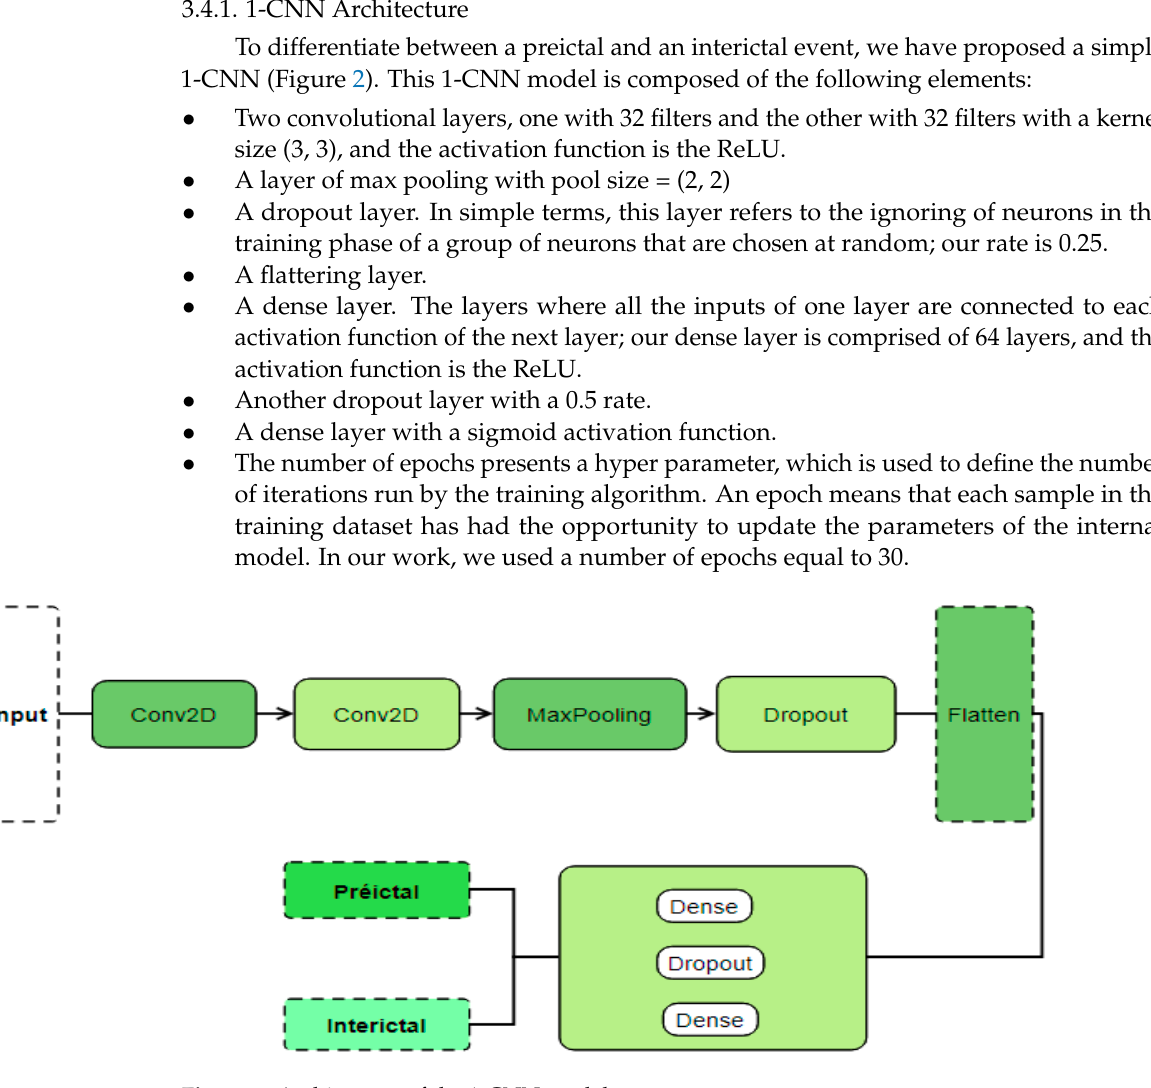
Figure 2. Architecture of the 1-CNN